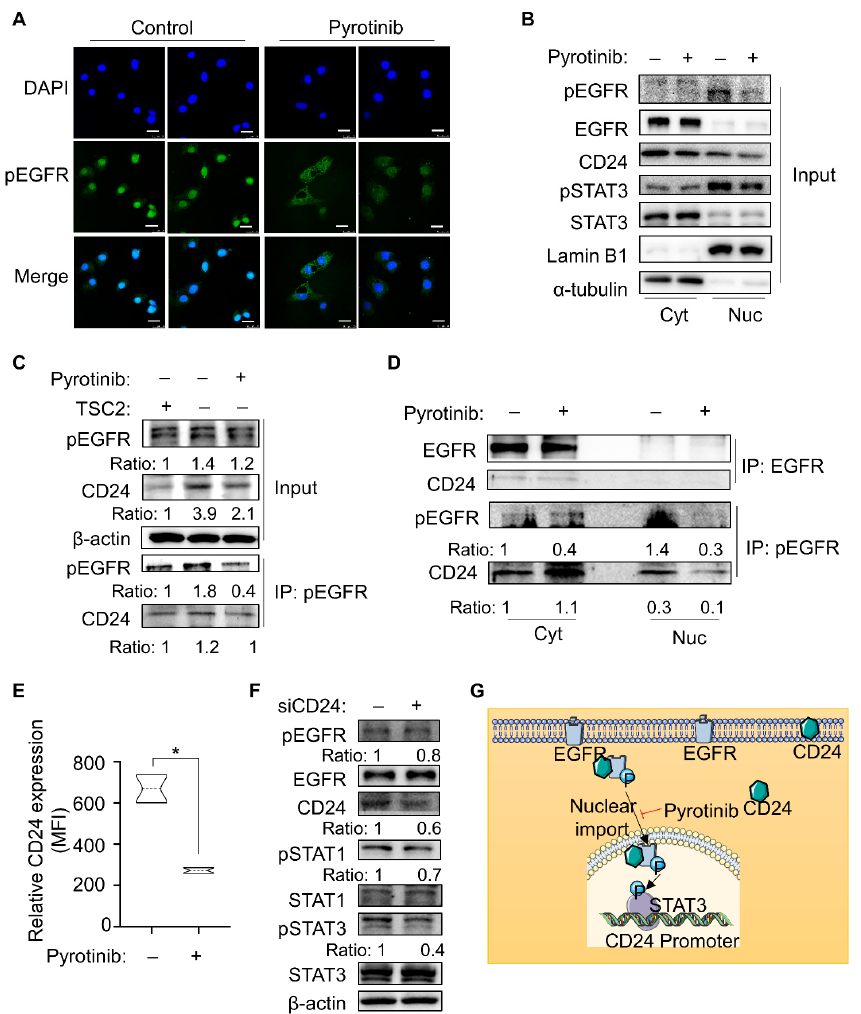
Figure 4. Binding with CD24 enhanced phosphor-EGFR function. ( A ) Localization and expression of pEGFR revealed by immunofluorescence staining in TSC2-deficient MEF-derived cells treated with or without pyrotinib (1 µ M). pEGFR (FITC-labeled) was expressed on both the cytoplasm and the nuclear, treatment with pyrotinib diffused the nuclear-accumulated pEGFR into the cytoplasm. DAPI was used for nuclear staining (magnification 630 × , bar = 25 µ m). ( B ) Cells were treated with pyrotinib (1 µ M) or not. Immunoblot analysis was used to detect indicated proteins (input) from the cytosolic and nuclear extracts. ( C ) MEF-derived cells treated with or without pyrotinib (1 µ M), and immunoblot analysis was used to detect proteins of cell lysates after incubated with antibodies of pEGFR (IP) or not (input). ( D ) Cells were treated with pyrotinib (1 µ M) or not. The cytosolic and nuclear extracts were subjected to immunoblot analysis using antibodies against EGFR or pEGFR (IP). ( E ) Flow cytometry was used to measure the mean fluorescence intensity of CD24 in TSC2-deficient cells treated with or without pyrotinib (1 µ M), which was co-incubated with CD24 antibodies ( n = 3). * p < 0.05, Student t test. ( F ) Immunoblot analysis of proteins in TSC2-deficient cells transfected with siCD24 or not. ( G ) Schematic illustration of this study. Pyrotinib restrained phosphorylation and nuclear translocation of pEGFR and directly suppressed the expression level of CD24 by inhibiting pEGFR/pSTAT3, pSTAT3 transcriptionally binding with the promoter region of CD24, and pEGFR/pSTAT3 pathway reduced the nucleocytoplasmic ratio of CD24, thus forming a positive feedback